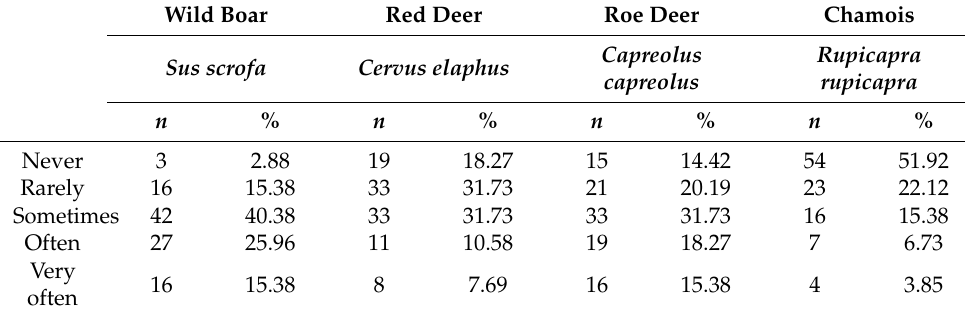
Table 2. Wild game meat consumption of the sample.